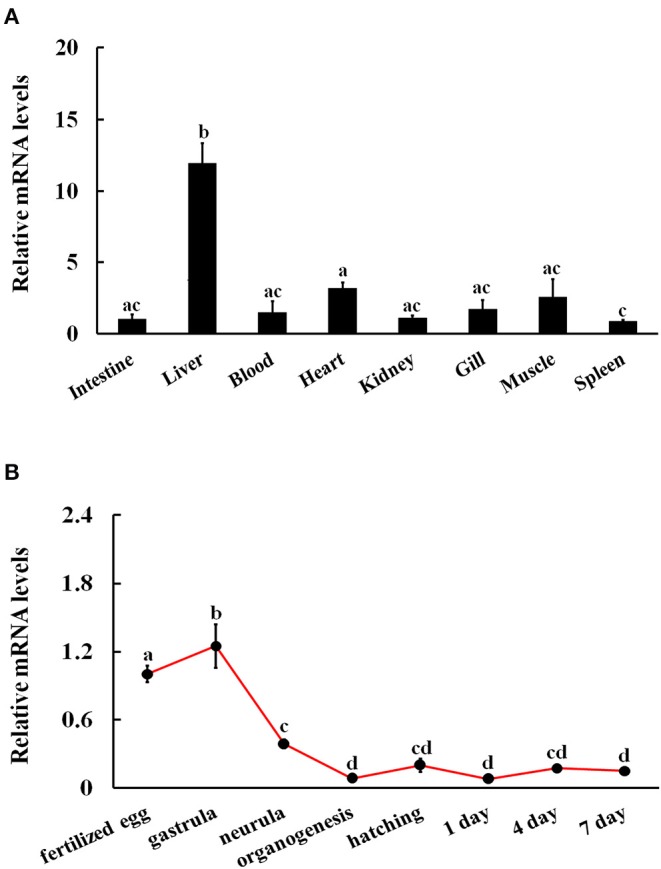
Relative expression levels of CiJNK mRNA in different adult tissues (A) and developmental stages (B). Grass carp β-actin was used to normalize mRNA levels in adult tissue and embryonic developmental stage samples. Each bar represents the mean of the normalized expression levels of the replicates (N = 3). Data without shared letters were significantly different (P < 0.05).